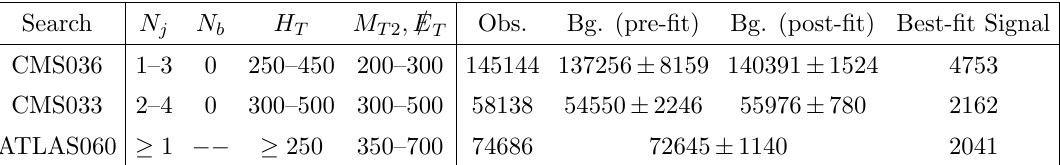
Table 1 . Regions of kinematic space containing the excess, and relative observed and background event counts, as well as number of signal events after the (cid:12)t. For the background, we quote both the pre- and post-(cid:12)t values for the expected counts and the relative